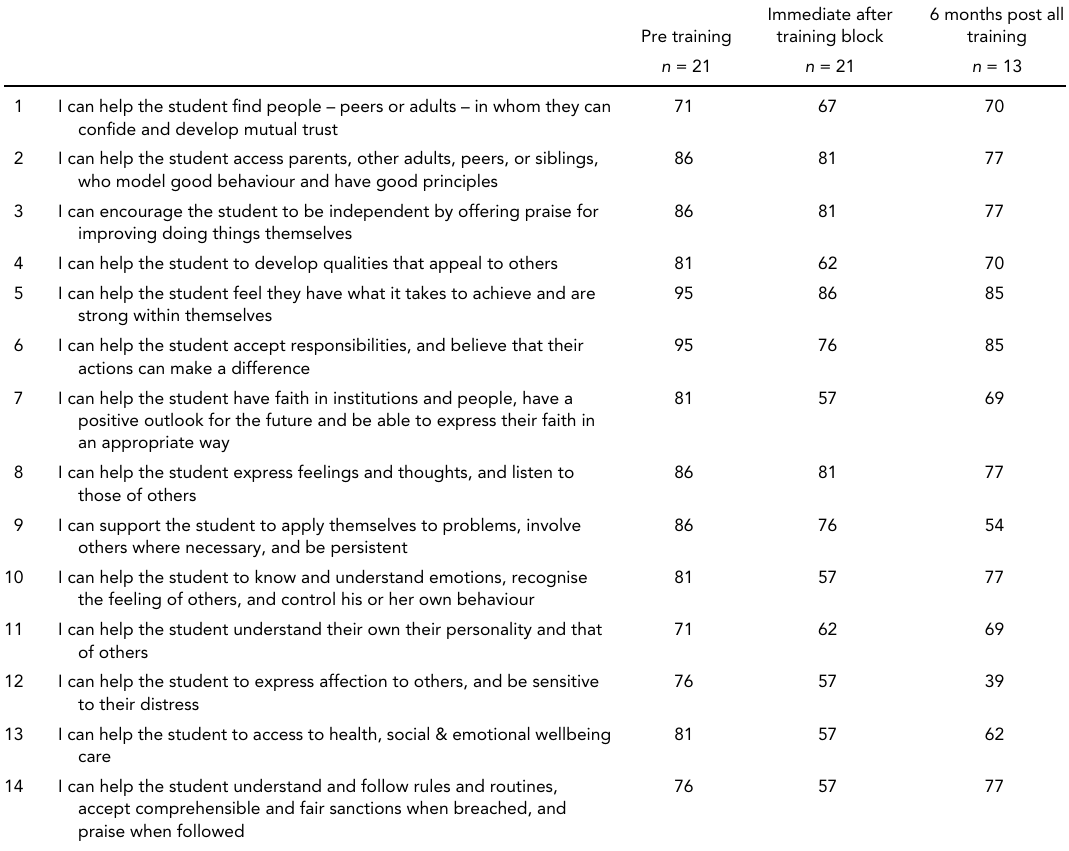
Percentage of Staff Agreement for Student Support Skills Indicators at Each Measurement Point